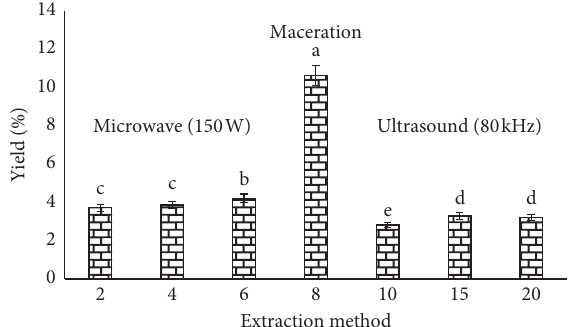
Figure 1: Effects of different methods on extraction yield of C. dactylon rhizomes (different letters indicate statistically significant differences between groups as determined by the Duncan test ( p < 0 .